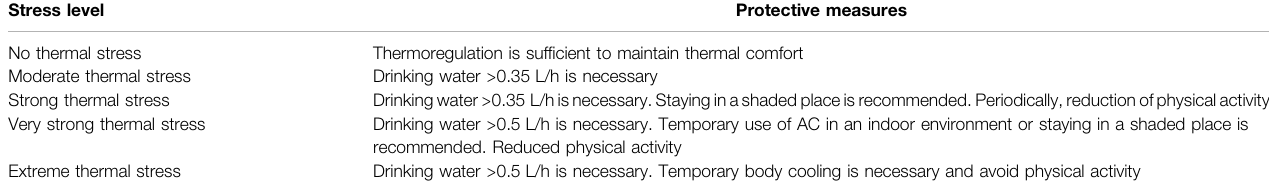
Extreme thermal